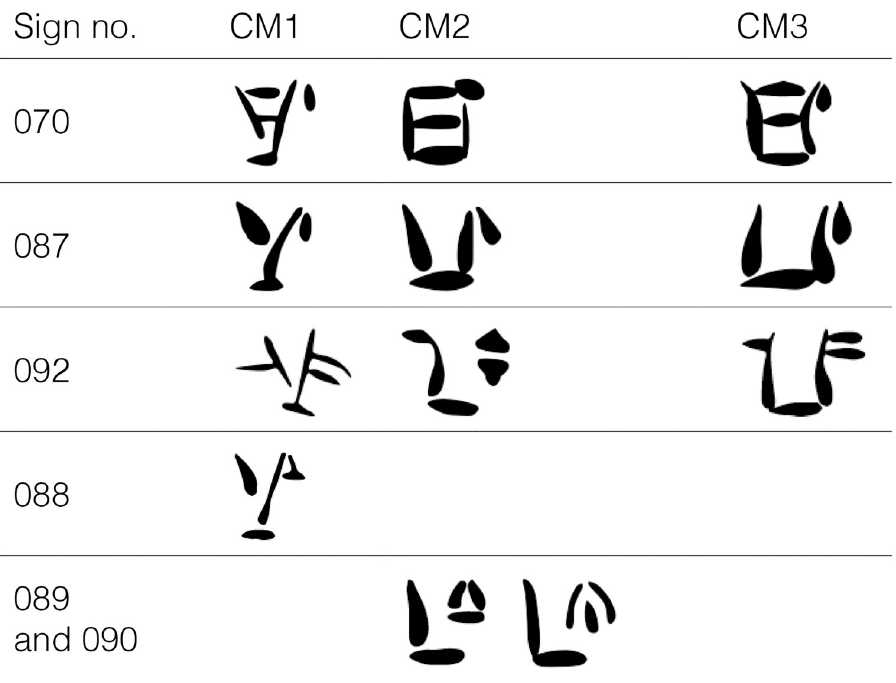
Fig 2. Incoherent classification of signs 070, 087 and 092 vis-a-vis 088, 089, 090 in [5] (after [3]).